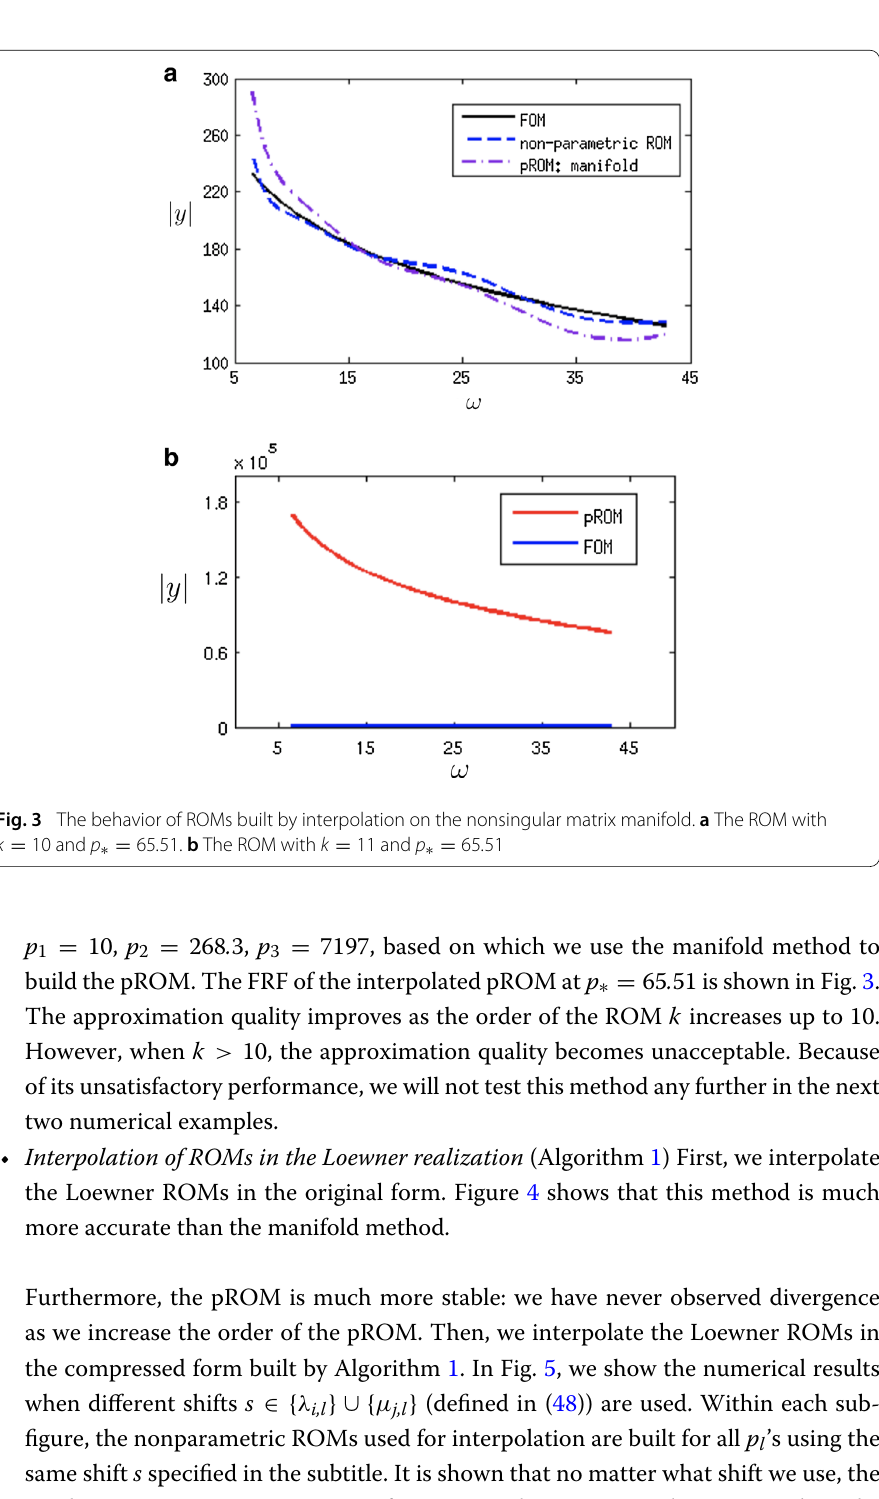
p 1 = 10, p 2 = 268 . 3, p 3 = 7197, based on which we use the manifold method to build the pROM. The FRF of the interpolated pROM at p ∗ = 65 . 51 is shown in Fig. 3. The approximation quality improves as the order of the ROM k increases up to